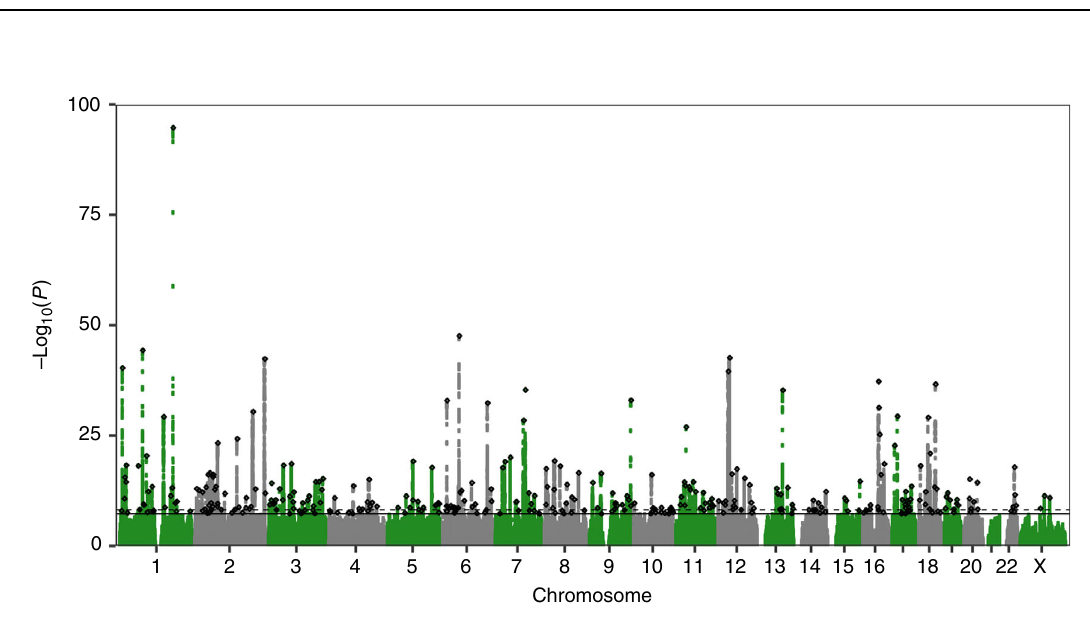
Fig. 1 Manhattan plot of the chronotype meta-analysis GWAS. The solid line indicates the typical genome-wide signi fi cance threshold of P = 5 × 10 − 8 and the dashed line marks the threshold of P = 6 × 10 − 9 identi fi ed through permutation testing. Lead variants are annotated with a